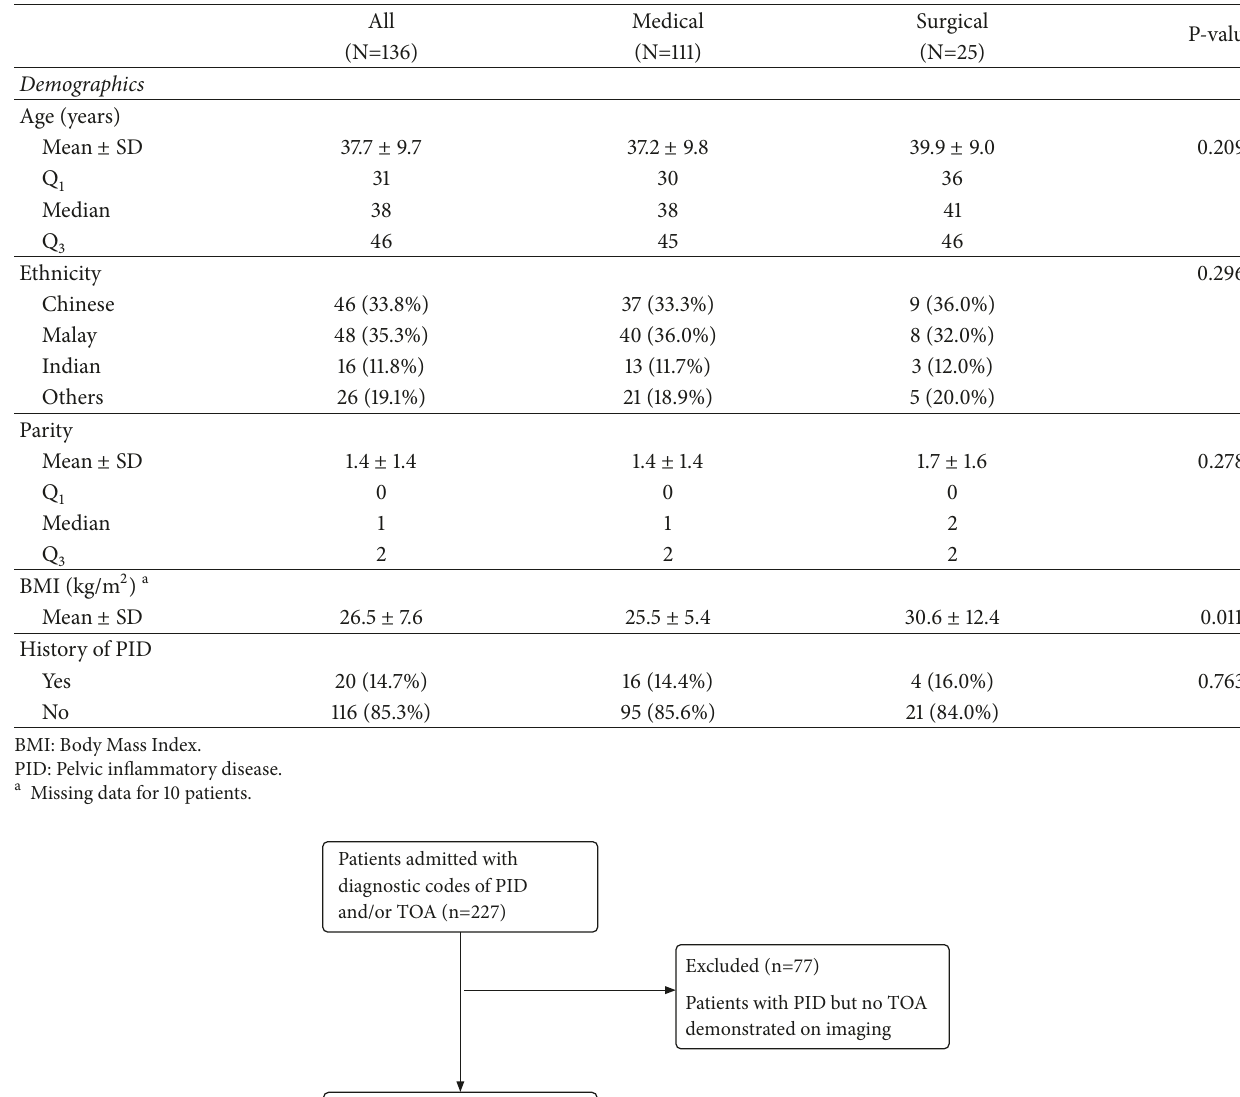
Table 1: Demographic characteristics and comparison between the two groups.